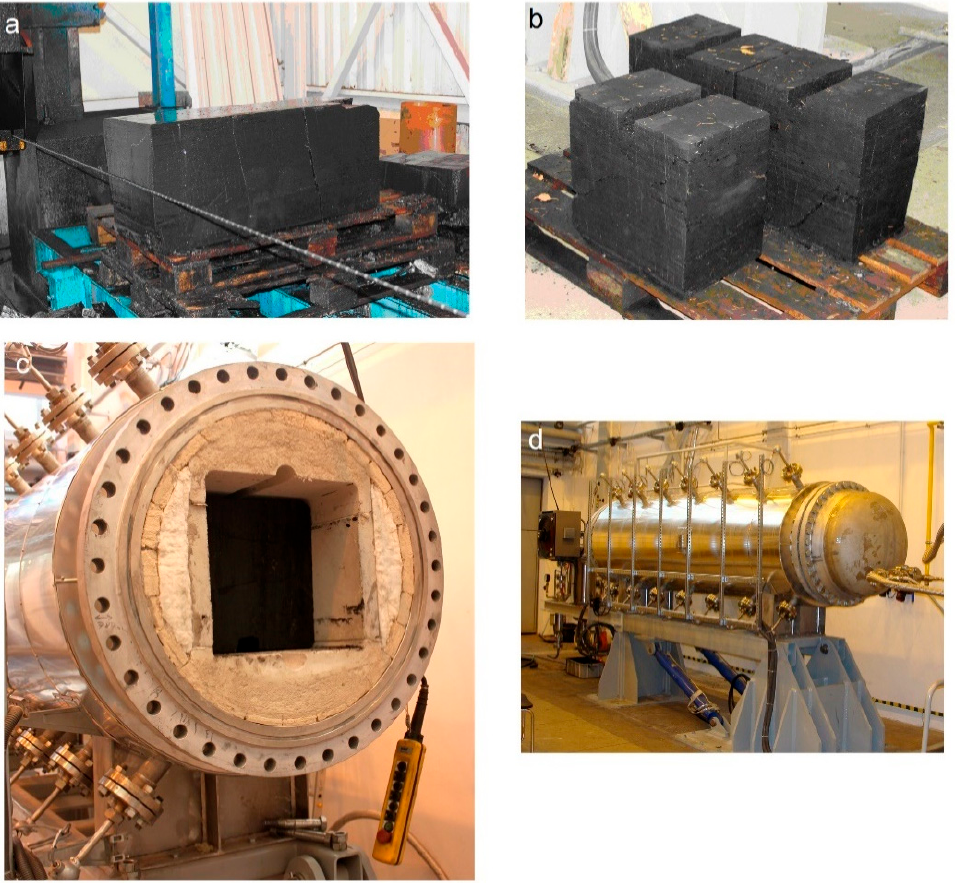
Figure 2. Preparation of coal for gasification. ( a ) Cutting block of coal, ( b ) coal blocks with a cut-out fire channel ready to be placed inside the reactor, ( c ) reaction chamber while loading with coal blocks, ( d ) reactor prepared for